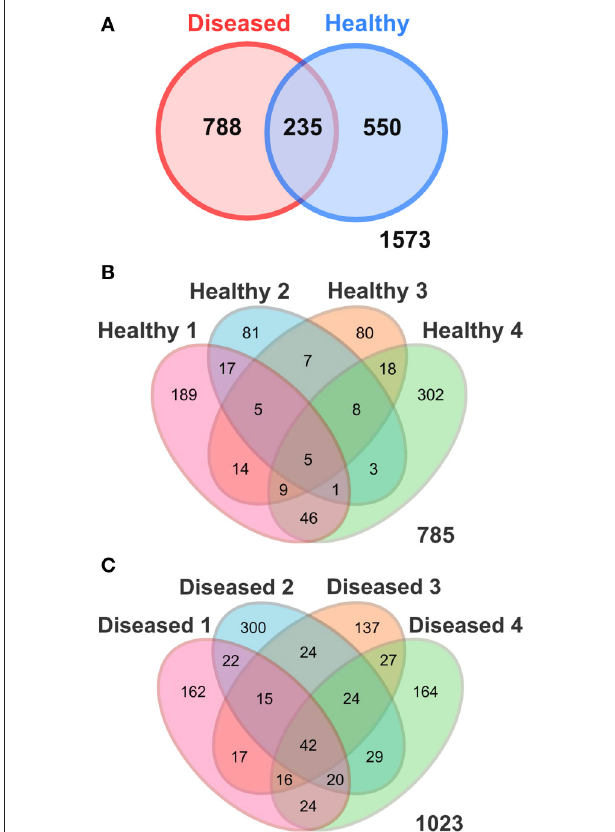
FIGURE 2 | Venn Diagrams illustrating the number of shared OTUs (97% sequence similarity) (A) between the apparently healthy and diseased P. carnosus tissues; and among the replicates of (B) the apparently healthy and (C) the diseased tissues detected in P. carnosus by pyrosequencing. Healthy, apparently healthy tissues of SGA affected P. carnosus colonies; Diseased, diseased tissues of SGA affected colonies.